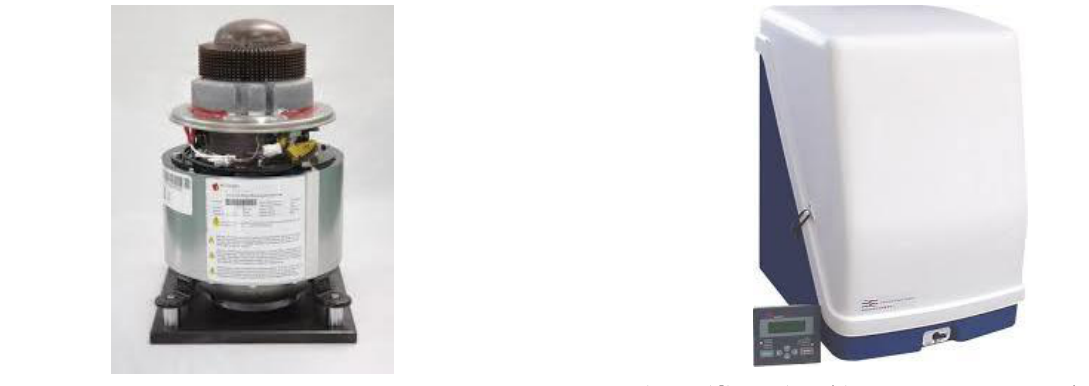
Fig. 3. One-cylinder Microgen, power 1 kWe [5]